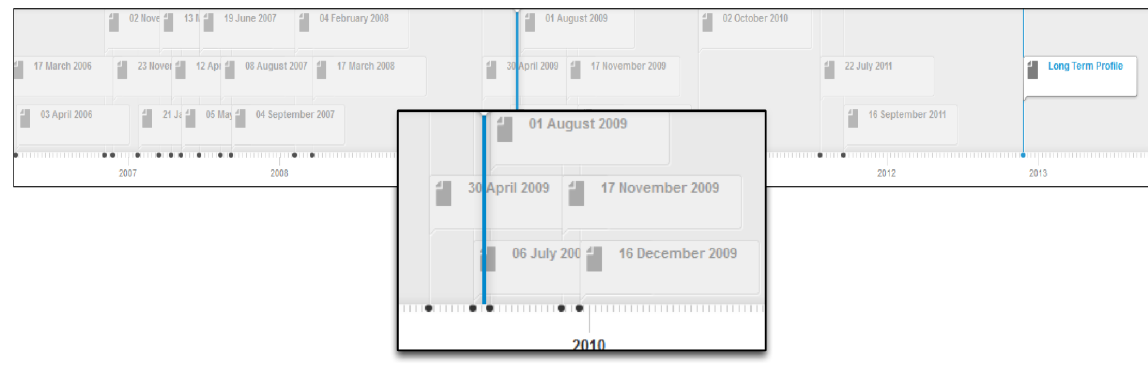
Figure 4. Profile timeline for user Jpkamil.